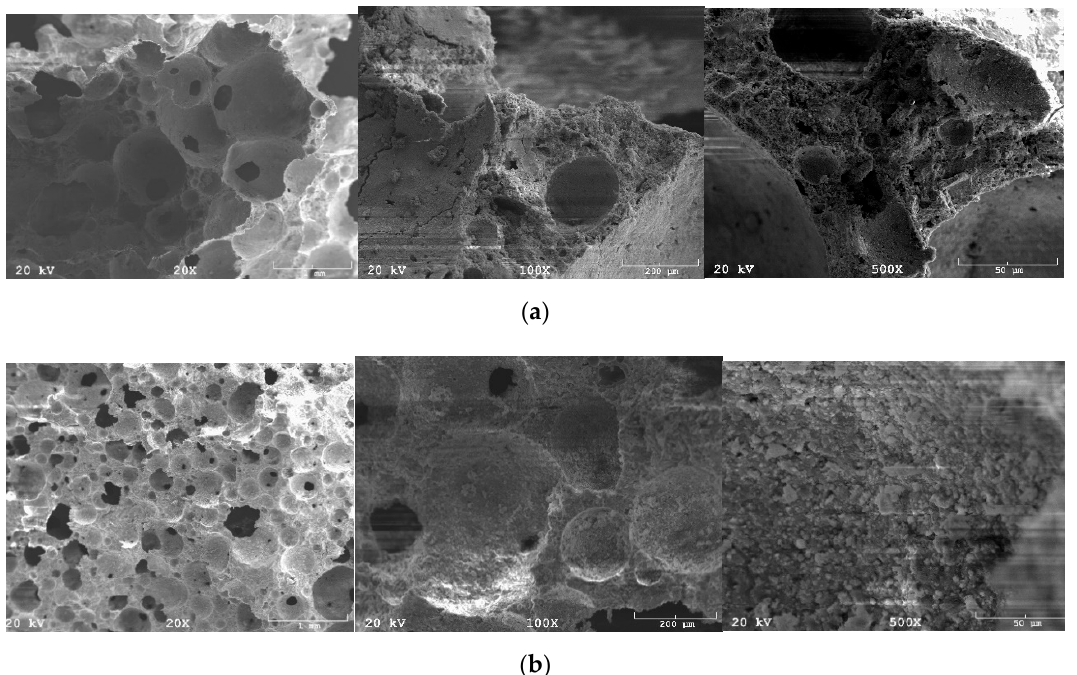
Figure 8. The micrographs of ternary system binder foam observed with SEM. ( a ) GCP-BG-1, ( b ) GCP-PG-1.